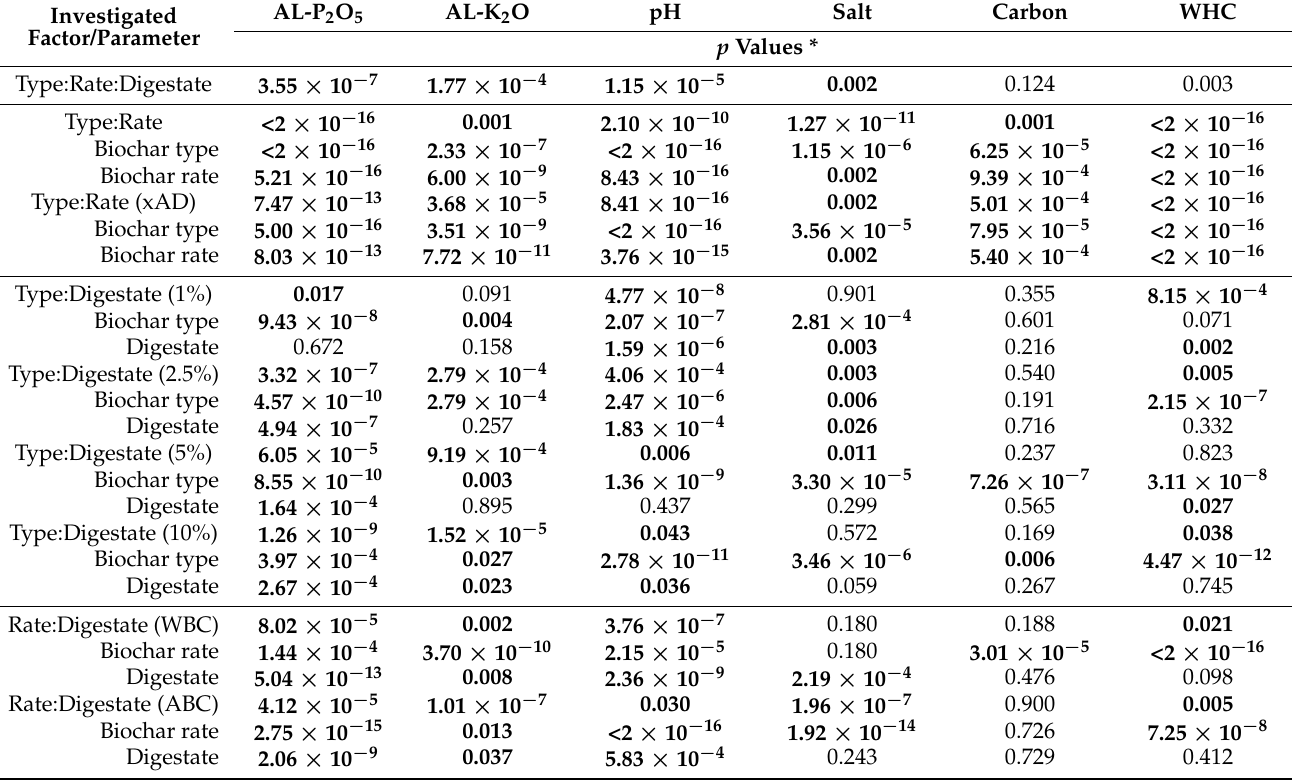
Table 3. Effects and interactions of the investigated factors on soil physical and chemical characteris- tics in the investigated soil